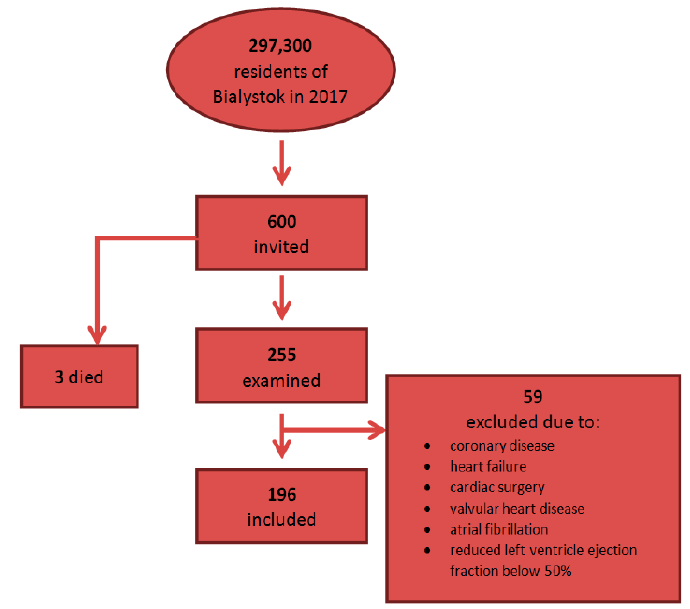
Figure 1. Analyzed cohort of 196 included individuals.